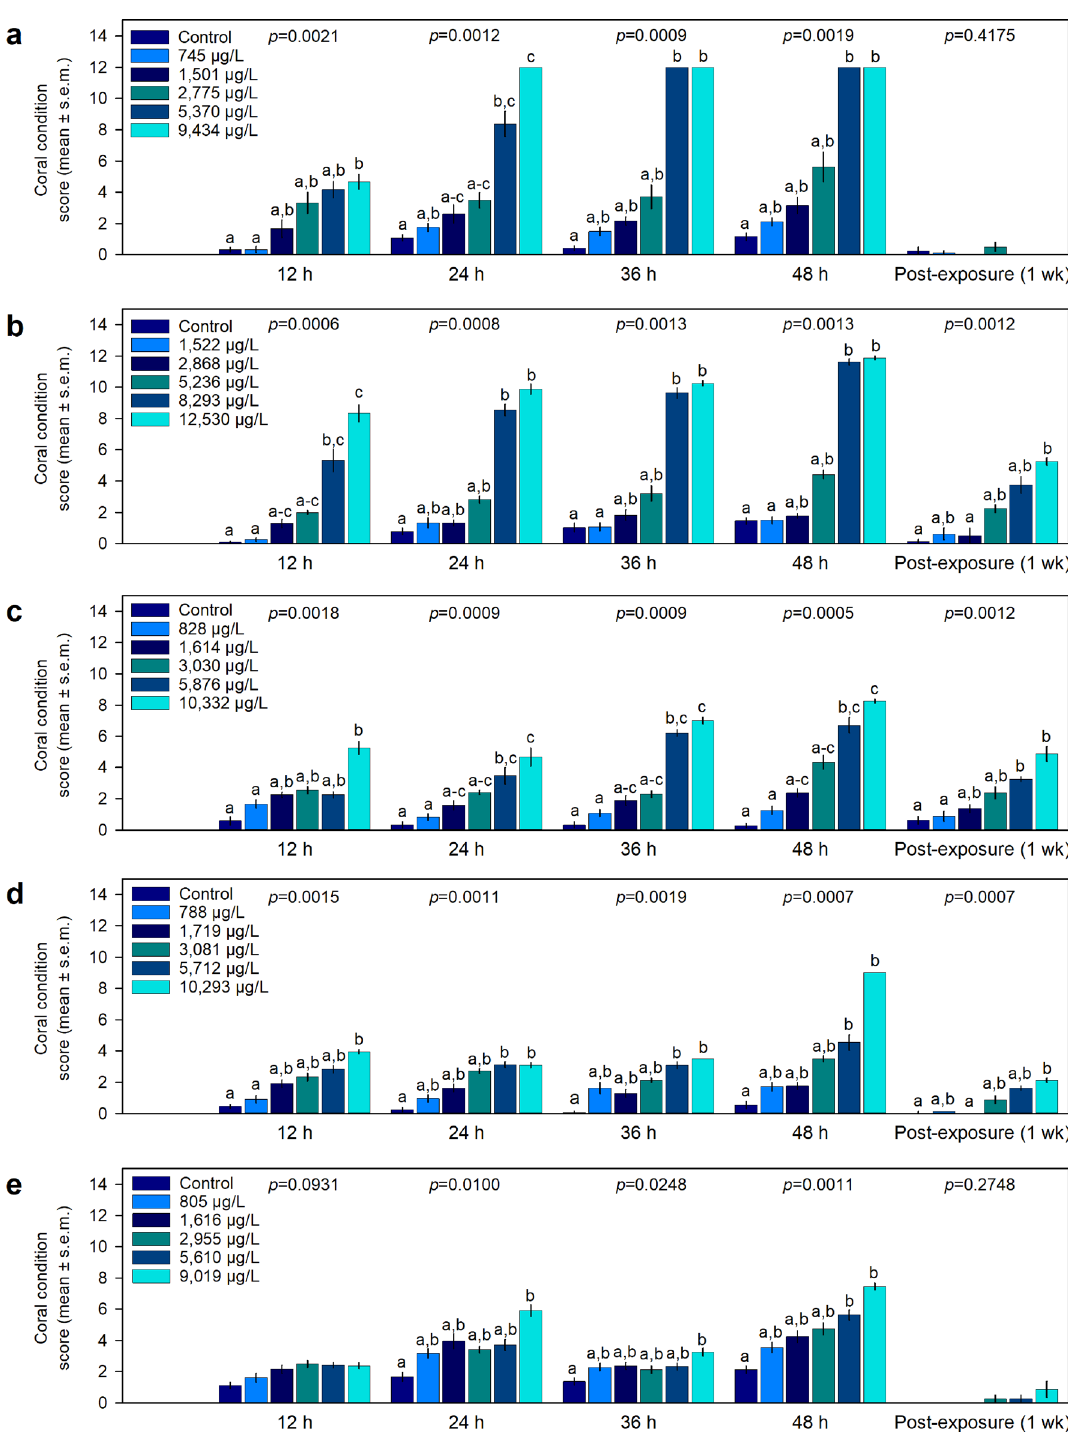
Figure 2. Coral condition scores (mean ± s.e.m.) (n = 4 replicates) during 1-methylnaphthalene exposures at 12 h, 24 h, 36 h, 48 h and 1 week post-exposure. ( a ) Acropora cervicornis , ( b ) Porites astreoides , ( c ) Siderastrea siderea, ( d ) Solenastrea bournoni , and ( e ) Stephanocoenia intersepta . Letters above each bar represent statistical differences between treatments at each time point ( a – c ; α =